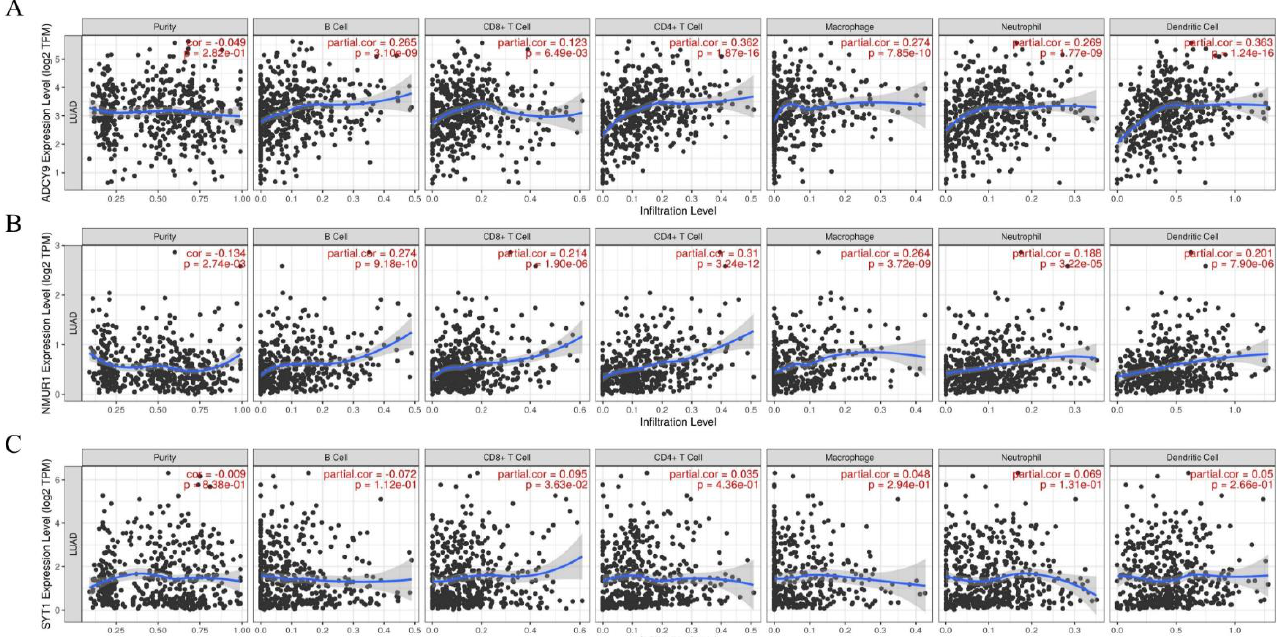
Figure 8. Correlation analysis of 3 hub-genes expression and tumor-infiltrating immune cells. ( A ) ADCY9 . ( B ) NMUR1 . ( C ) SYT1 .